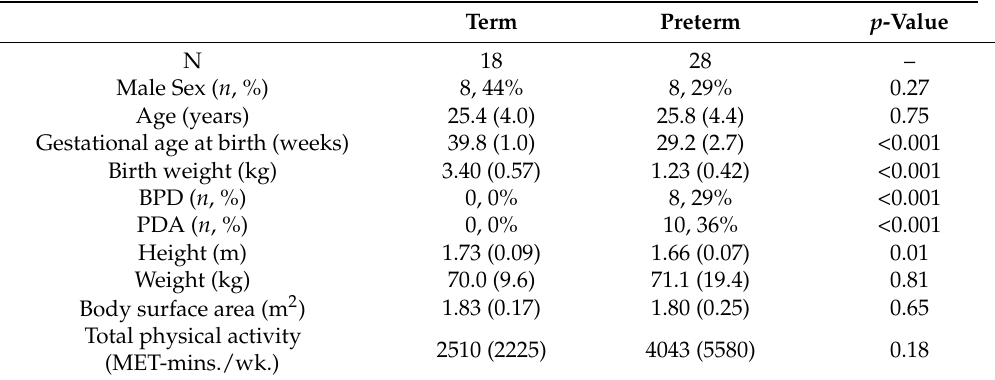
Table 1. Baseline